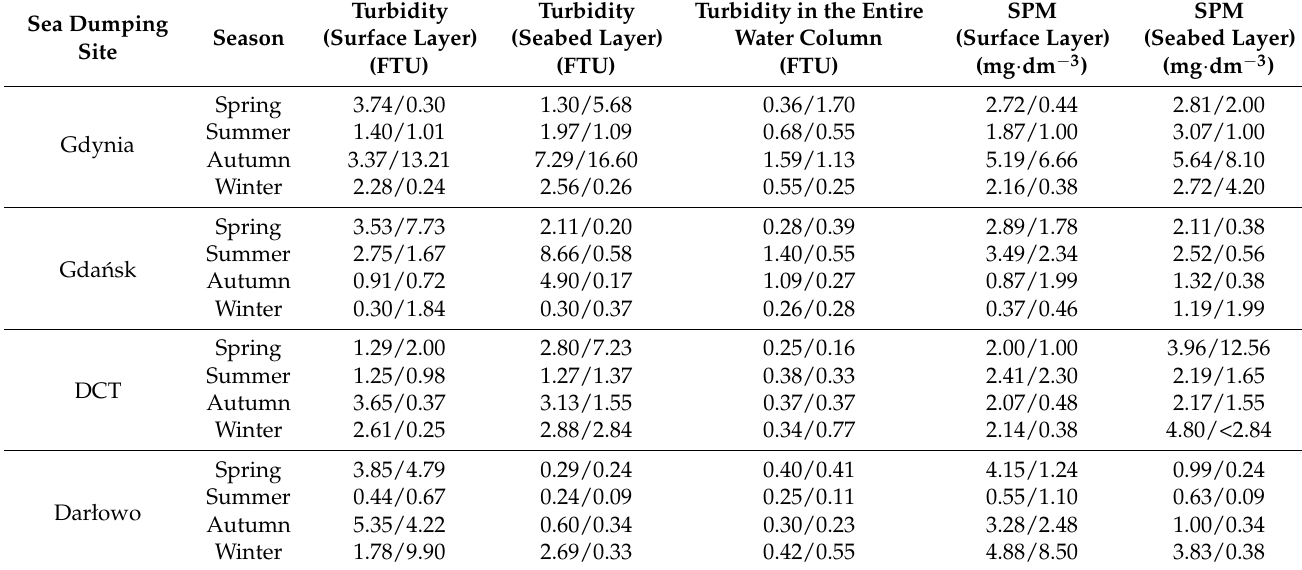
Table 3. Turbidity and SPM concentrations averaged for all of the sampling sites of the given dumpsites and the appropriate layer (before the slash) versus data averaged at the reference points (after the